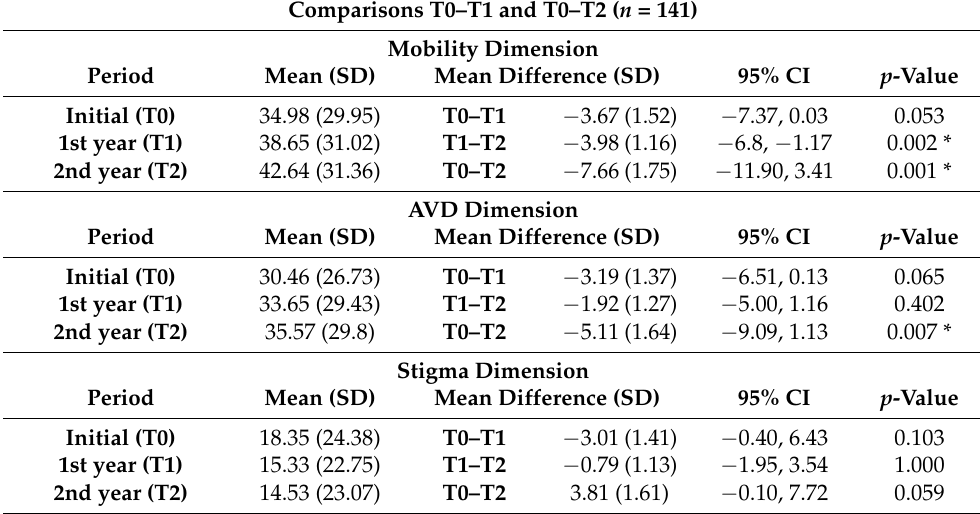
Table 3. Evolution of HRQoL considering the total scores of each of the PDQ-39 dimensions for the patients that completed